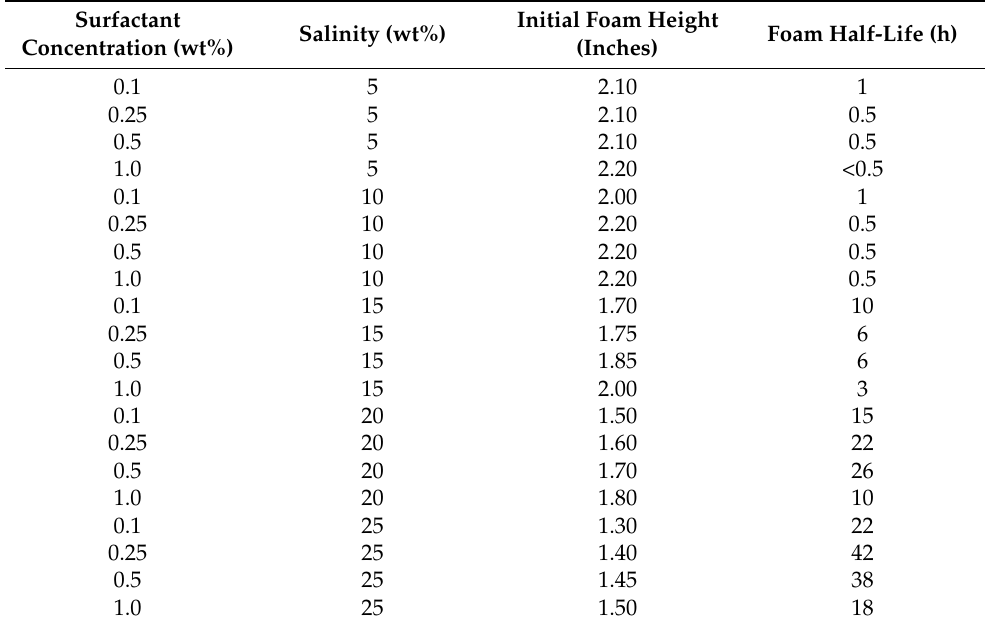
Table 2. Foam half-life of EC12 at room temperature and pH